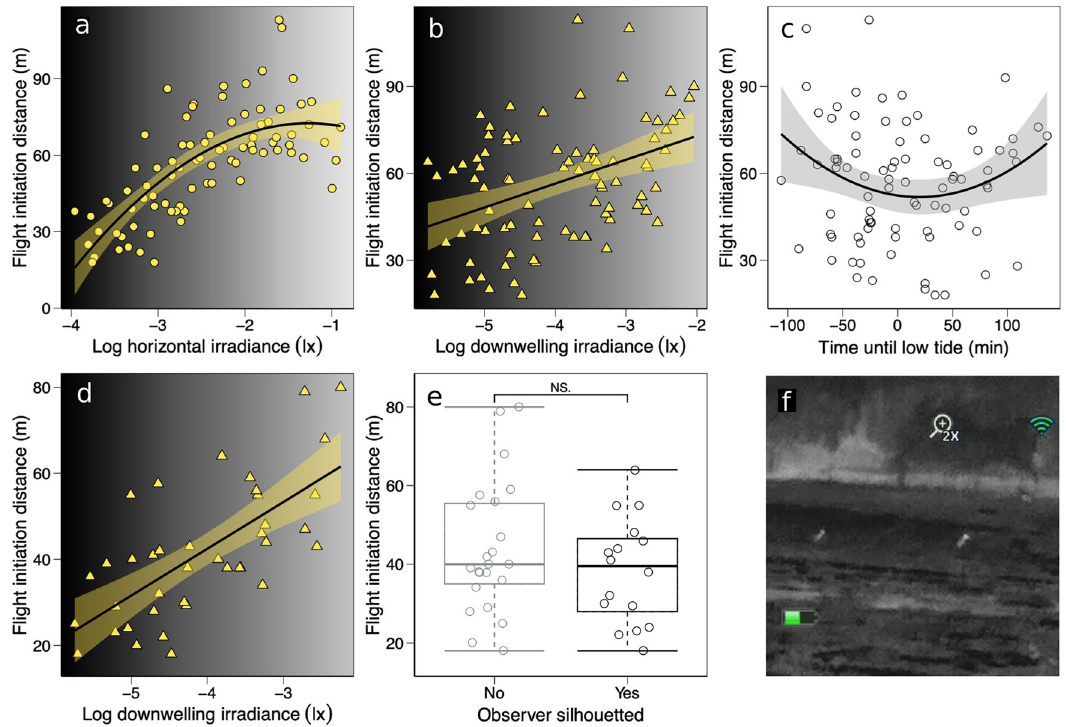
Fig. 1 Nocturnal light environment affects curlew FID. Regression plots show how the higher intensity of horizontal ALAN a and downwelling light b increased curlew FIDs. c FIDs were shorter around the lowest stage of the low tide period ( n = 86 in plots a – c ). When considering only the measurements taken in the ‘ creek ’ where the levels of horizontal ALAN were low, FID was strongly in fl uenced by downwelling light d . Foraging curlew were approached from different directions (i.e., being silhouetted against the horizontal arti fi cial lights or a dark woodland), but this did not have a signi fi cant effect on FID e . f Two curlews observed through the thermal camera at night ( n = 39 in plots d , e ). Table 1 Results of the best linear model explaining curlew ’ s FID at night. Variable